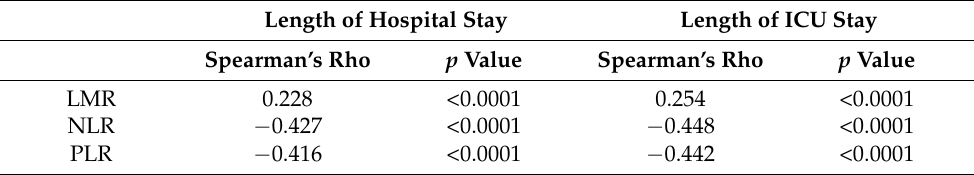
Table 2. The correlation of LMR, NLR and PLR with hospital stay and ICU stay. Length of Hospital Stay Length of ICU Stay Spearman’s Rho p Value Spearman’s Rho